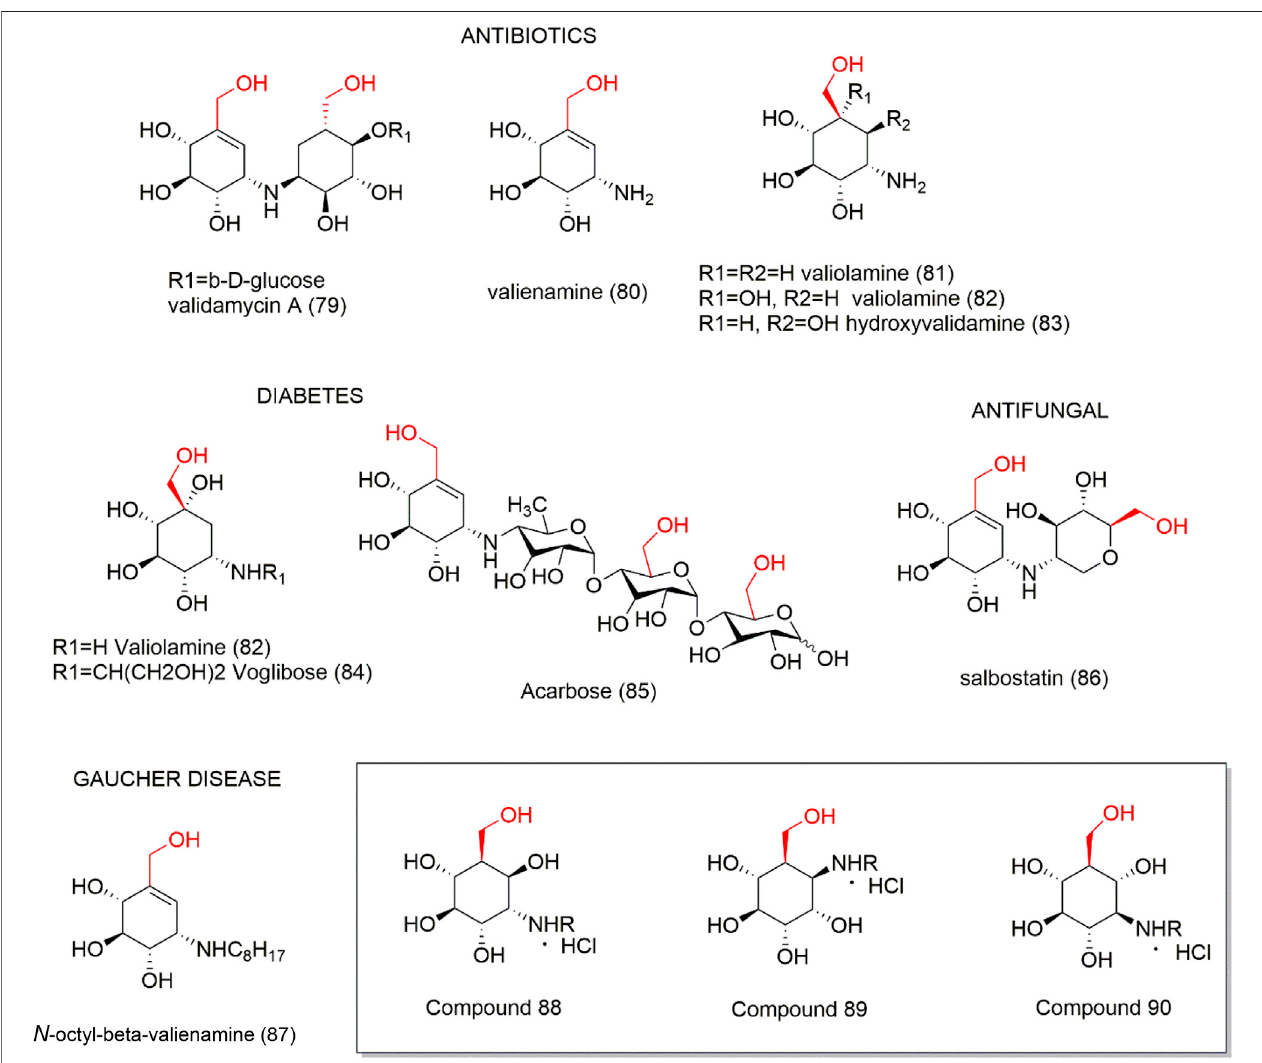
FIGURE 6 | Aminocyclitols containing hydroxymethyl substituent ( 79 – 90 ).